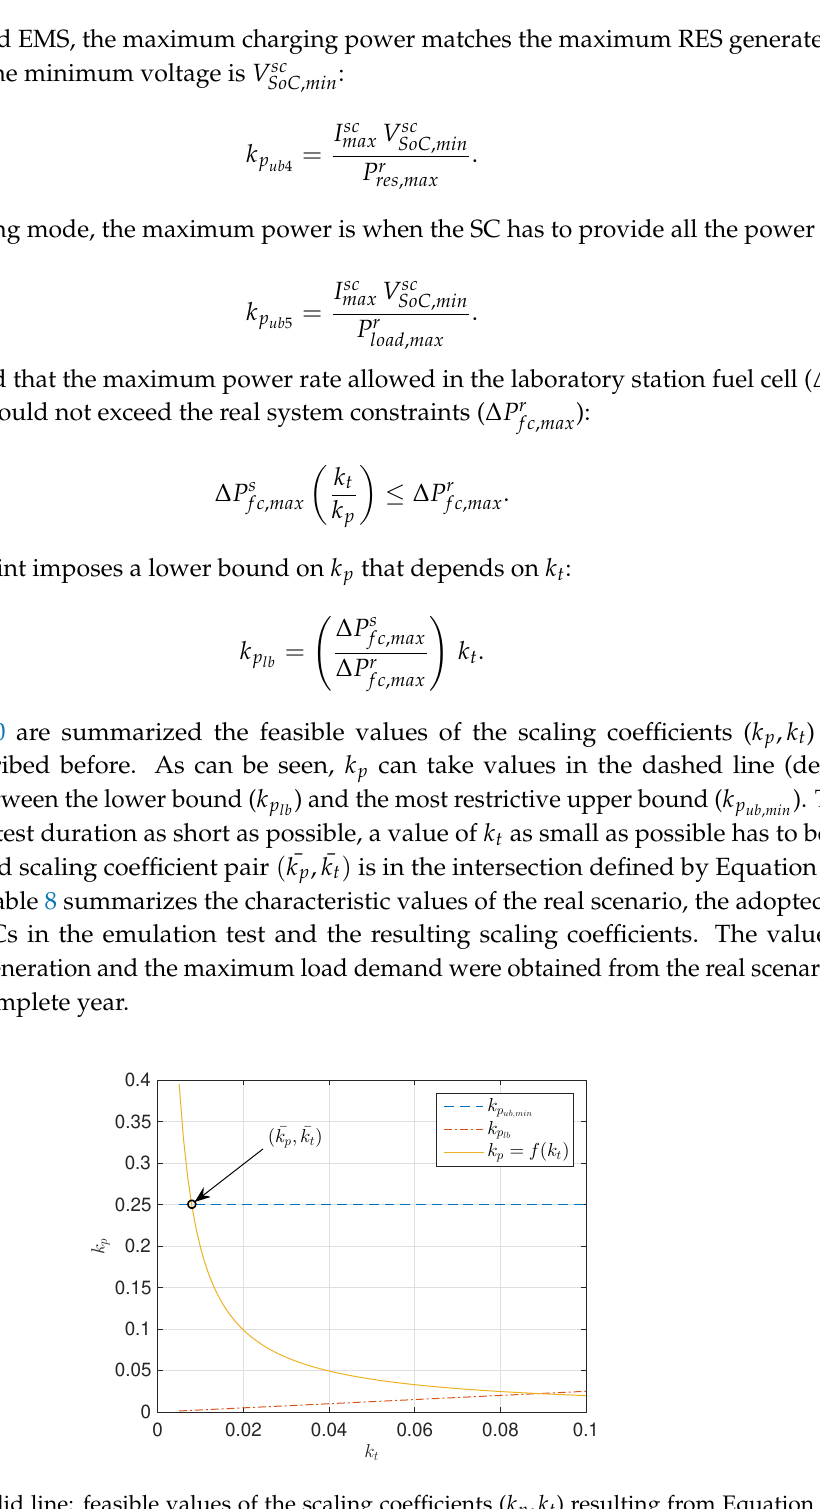
). o points to the adopted ub , min